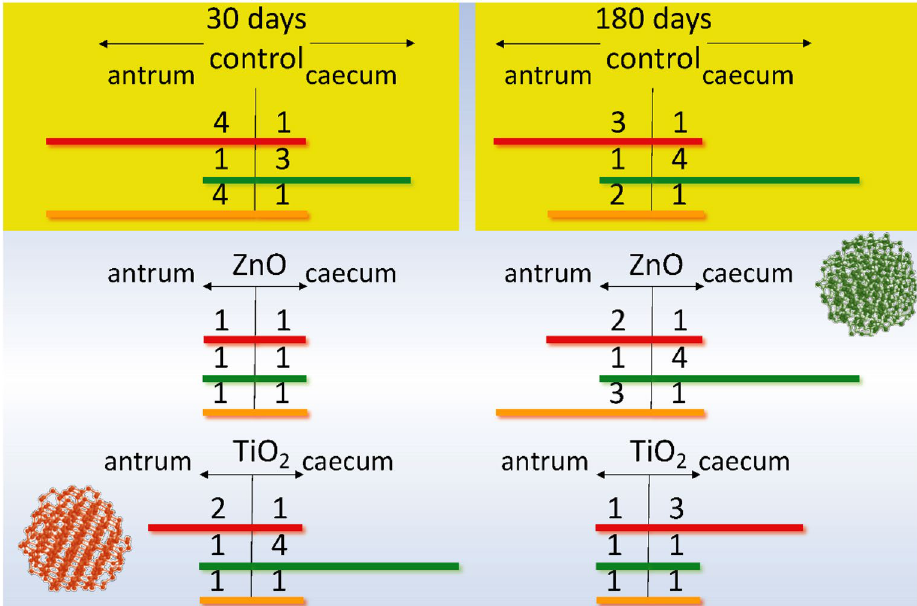
Figure 3. Schematic representation of the ratio of the parameters of spontaneous SM contractions of the antrum and cecum of rats in the control group and in the group intragastrically burdened with TiO 2 and ZnO ANs for six months: red —AU contraction indices; green —the frequency of spontaneous contractions of preparations per 10 min.; orange —an averaged value of the duration of contraction-relaxation cycle. A comparison of these and our previous study 2 results whereby rats were intragastrically burdened with ANs for 30 days.